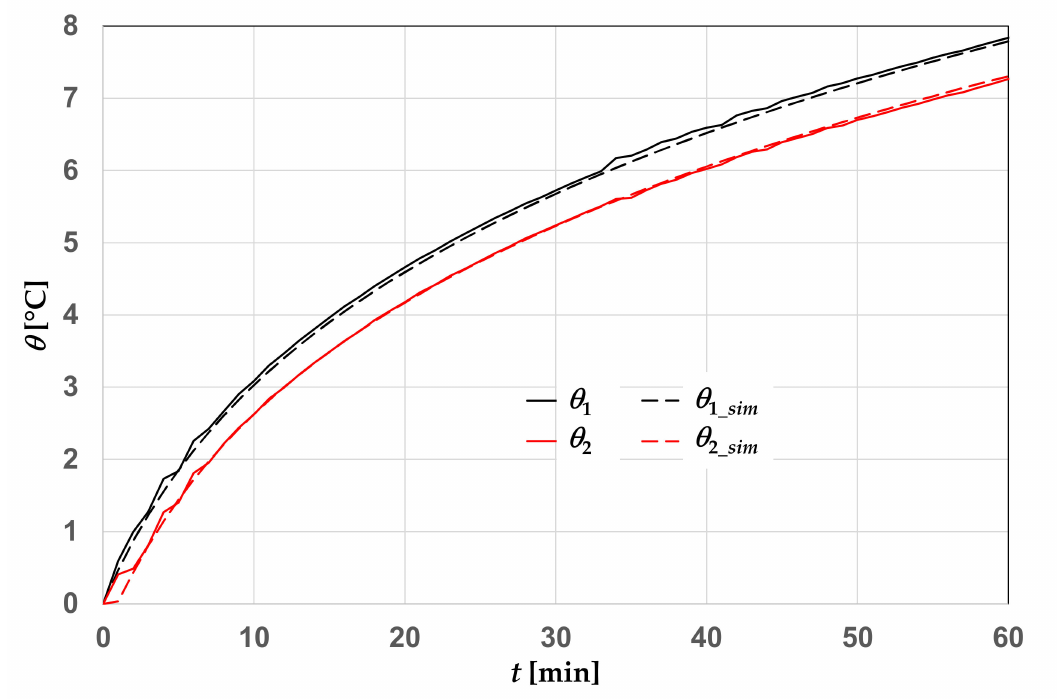
Figure 13. Time evolutions of θ 1 , θ 2 , θ 1_ sim , θ 2_ sim during the first hour, for k g = 0.863 W/(mK), ( ρ c ) g = 4.6 MJ/(m 3 K), k s = 3.22 W/(mK), and ( ρ c ) s = 3.0667 MJ/(m 3